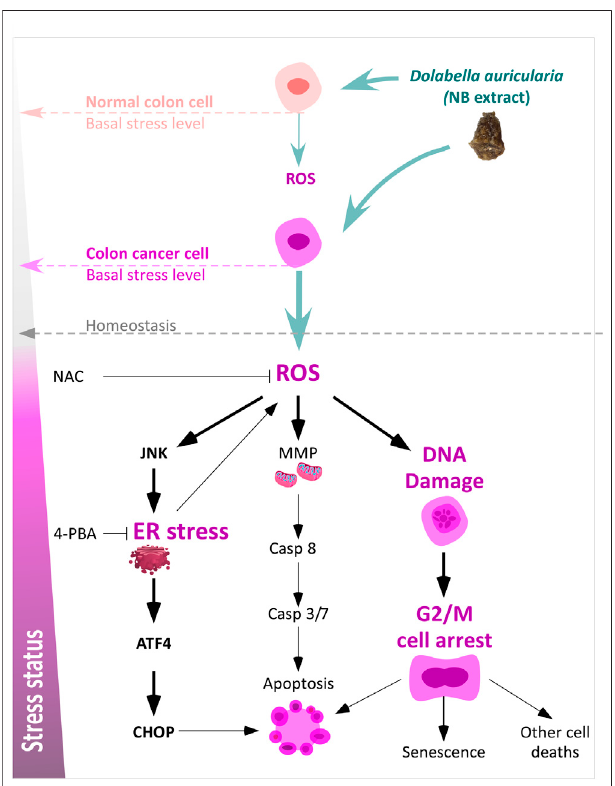
FIGURE 7 | Schematic diagram of the effect of NB extract on colon cancer cells including an increase in OS and ER stress and the different effect in normal colon cells associated with the basal stress